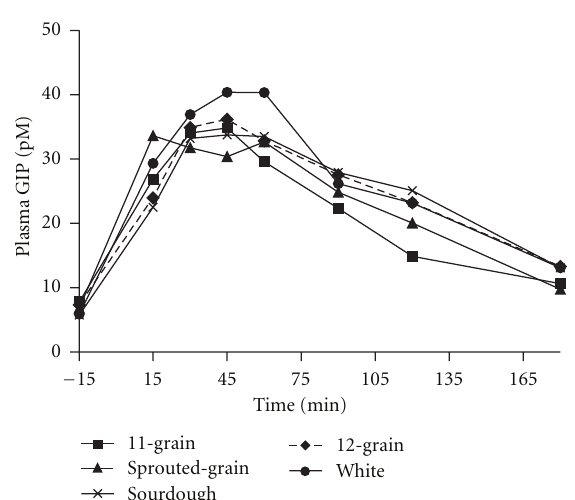
Figure 5: Fasting and postprandial GIP responses to the ingestion of a consistent amount of the test breads. Data are means. Standard errors are not included for clarity, n = 11. Test bread was ingested after collection of fasting blood sample at time point − 15 min. A significant overall treatment e ff ect was found (11-grain bread was lower than sourdough ( P < 0 . 008) bread).